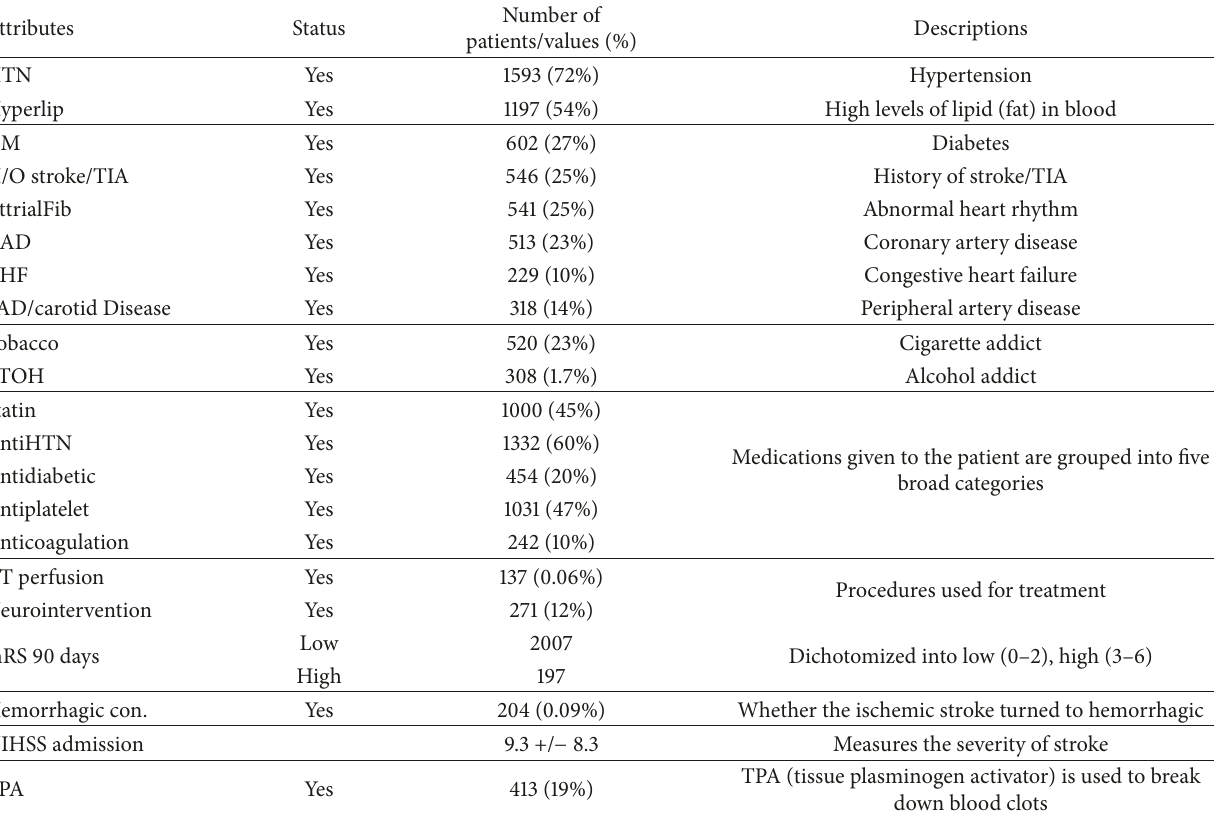
Table 3: Stroke dataset